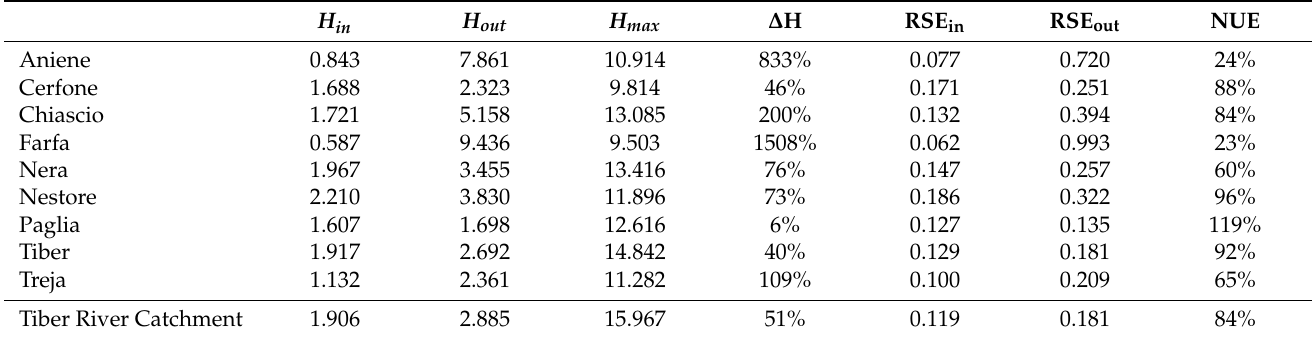
Table 4. Input and output entropy ( H in and H out , respectively), RSE, and NUE values for the assessment of the N performance concerning the Tiber River Catchment (TRC) system and its sub- catchments. Relative Statistical Entropy, RSE x = H x / H max (x = in, out), ∆ H = ( H out − H in / H in ) × 100 and NUE = N out /N in . The values of Nin and Nout for the TRC refer to those in Table 1. The values of N in and N out for each sub-basin are not reported